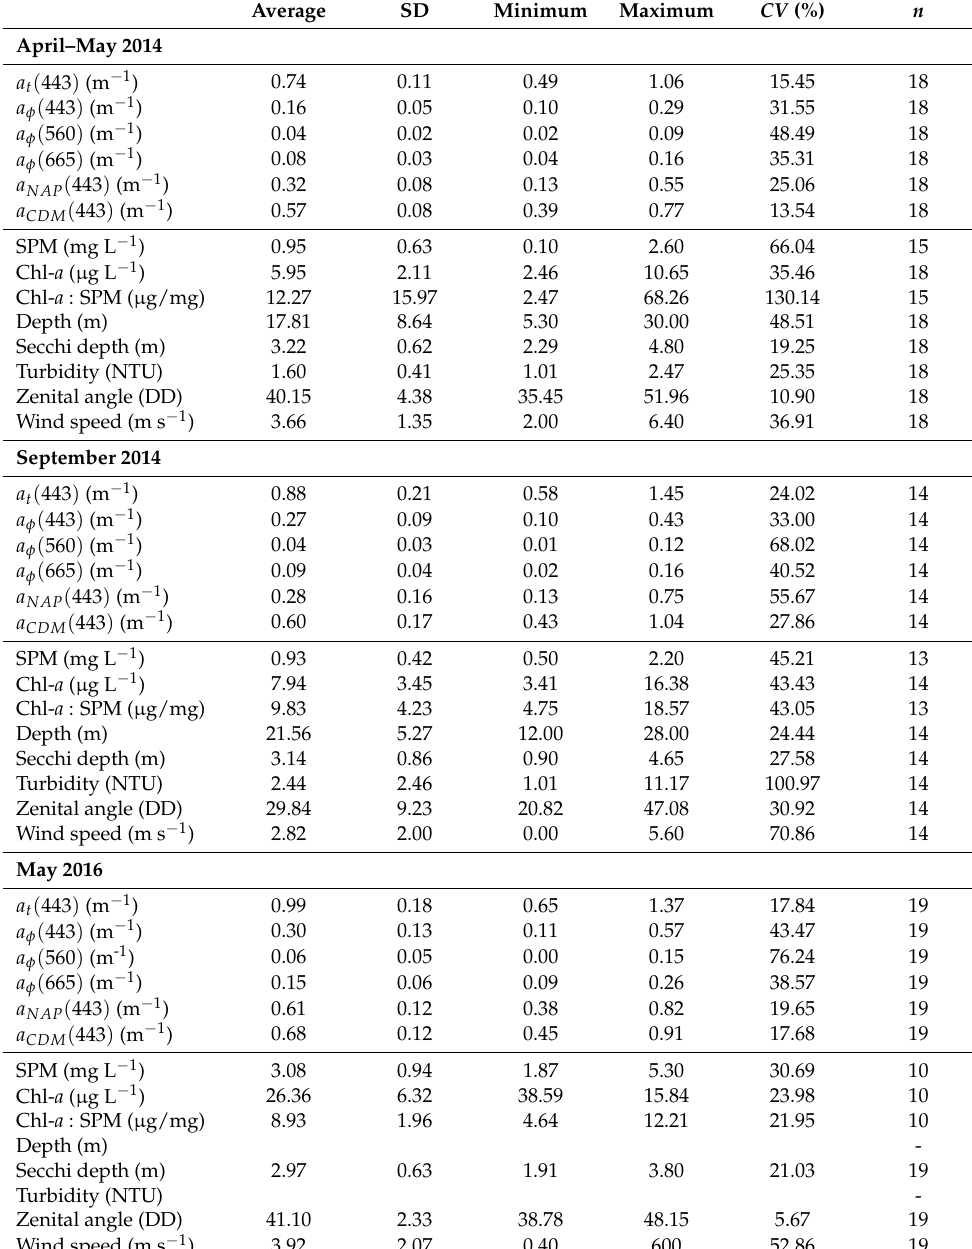
Table 3. Descriptive statistics of the water quality variables used for calibration and validation. SD is the standard deviation, CV is the coefficient of variation, and n is the number of